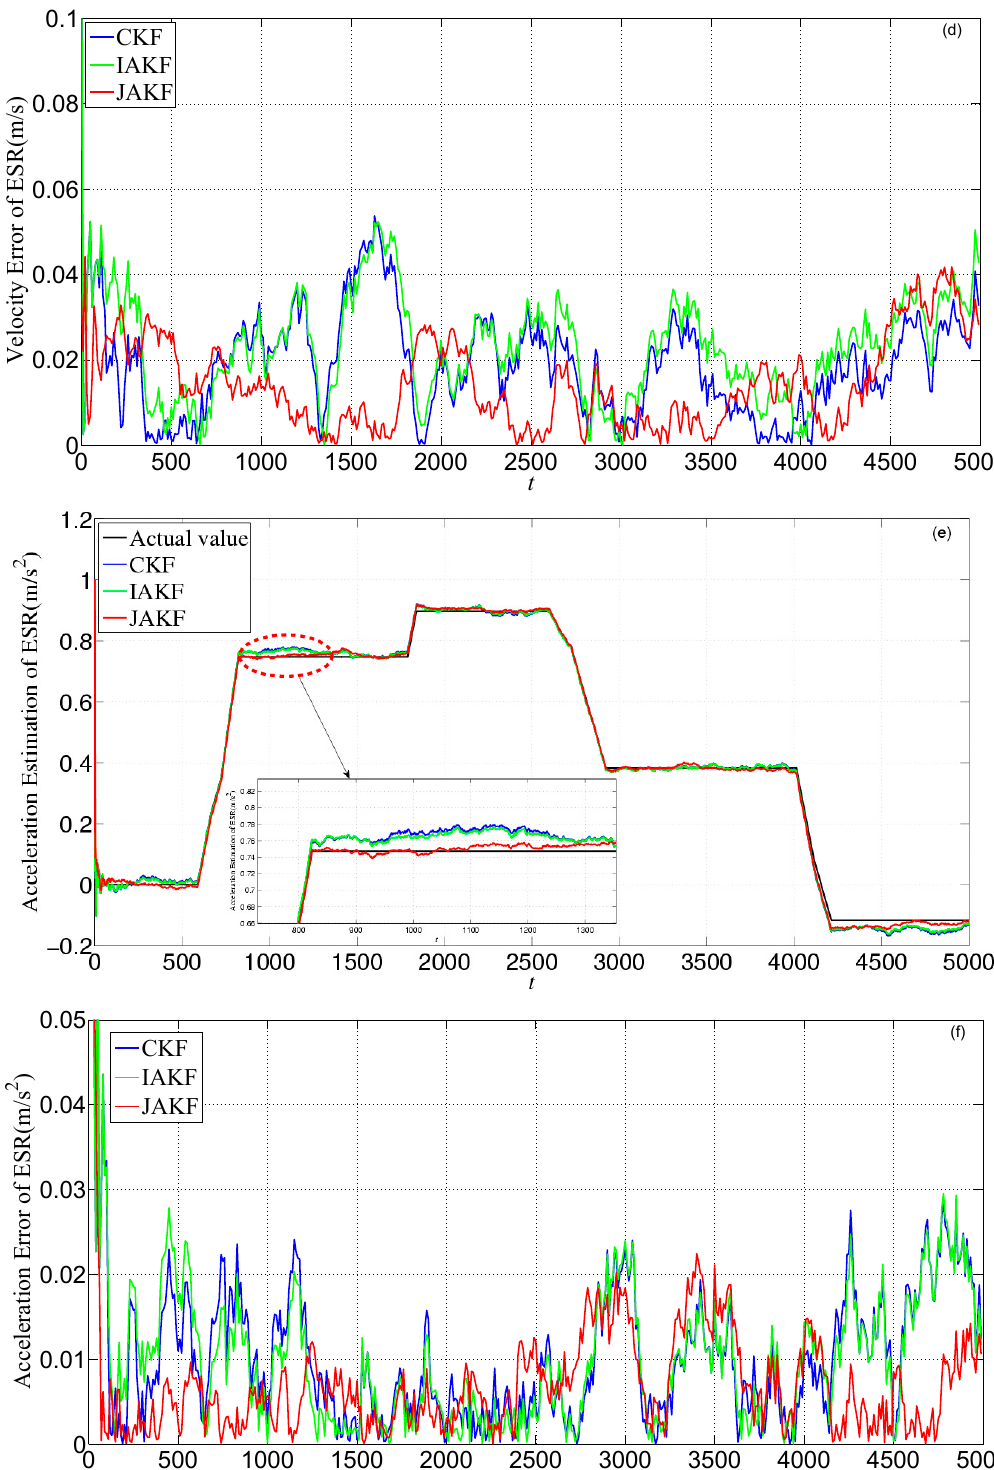
Figure 15. Estimation and error comparison of ESR in the second experiment: ( a ) Displacement estimation of ESR; ( b ) Displacement error of ESR; ( c ) Velocity estimation of ESR; ( d ) Velocity error of ESR; ( e ) Acceleration estimation of ESR; ( f ) Acceleration error of ESR. Table 4 lists the comparisons of CKF, IAKF and JAKF about root-mean-square error, maximum error, and variance of filtered results.